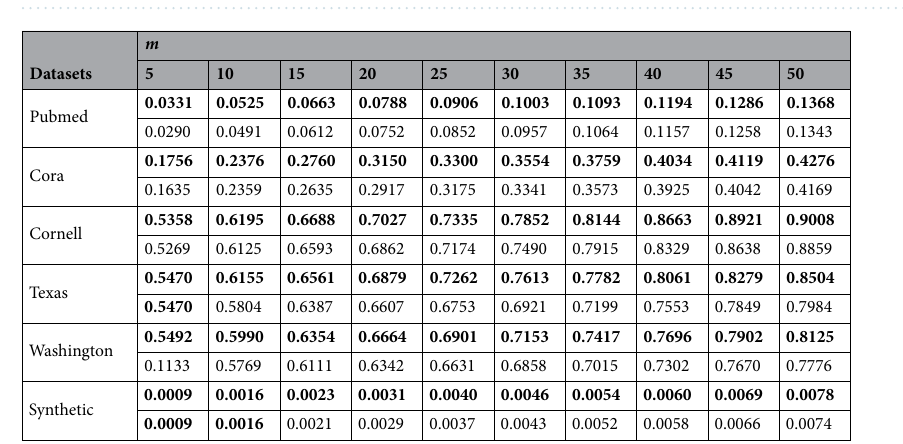
Figure 2. The influence spread σ( S ) of different algorithms on six datasets with different number of initial spreaders m under the IC model.